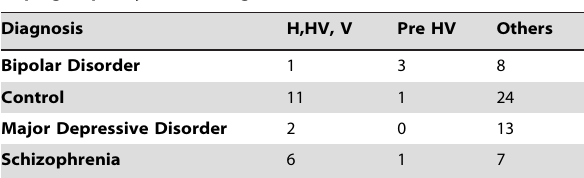
The chi-square for this table is (chi-square=13.7 (6), p=0.032). doi:10.1371/journal.pone.0004913.t002 PLoS ONE |